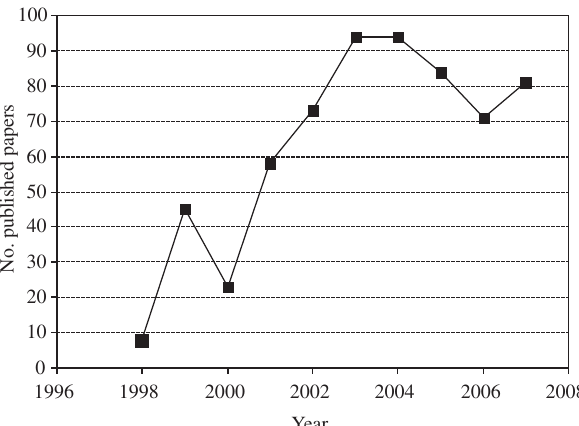
Figure 1. Number of published papers per year in Mat.